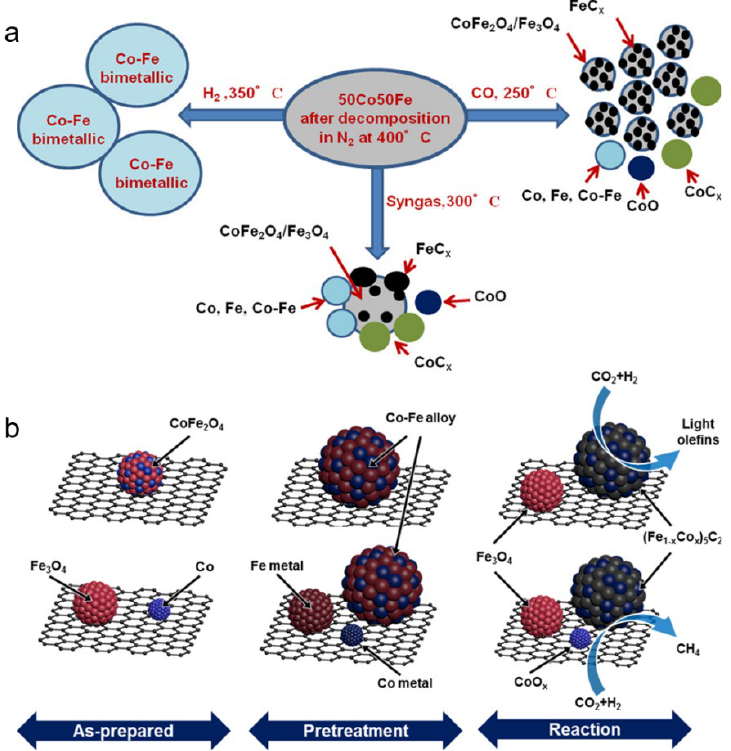
Figure 5. ( a ) Structures of Co–Fe bimetallic catalysts pretreated in different conditions. Reprinted with permission from ref. [35]. Copyright 2016 American Chemical Society. ( b ) The phase transformations of as-prepared spinel CoFe 2 O 4 NPs (top row) or (Fe 3 O 4 + Co) NPs (bottom row) on CNT supports during pre-reduction and reaction steps. Reprinted with permission from ref. [74]. Copyright 2020 American Chemical Society.